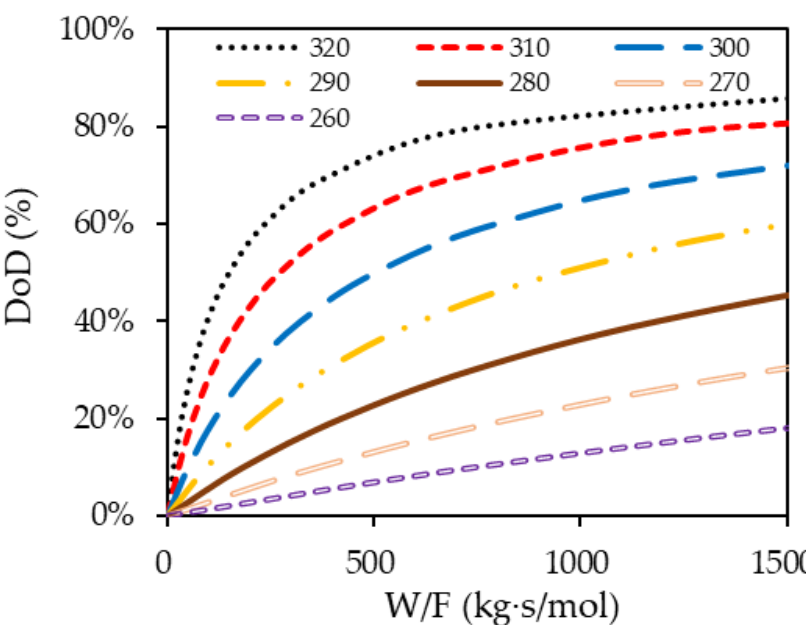
Figure 11. Solution of Equation (6) giving an achievable DoD for different W/F ratio at different temperatures supplied with fully hydrogenated LOHC+ in a PFR reactor.